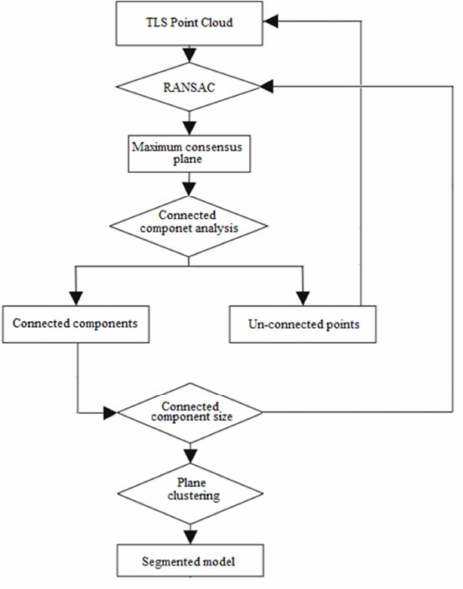
Figure 2. Workflow of the developed segmentation process for planar